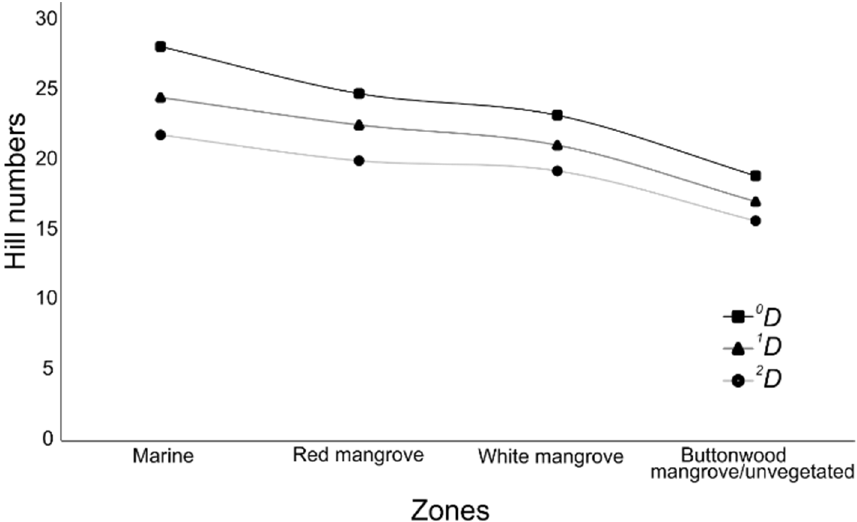
Figure 5. Average value of the three Hill numbers used in the different zones. For beta diversity, the nestedness component (species richness differences) did not show significant differences between zones (t β sne < 1.6, p > 0.2), while the spatial turnover (species replacement) was different, due to the higher values in the ocean (t β stu > 28.94, p < 0.01) compared to the rest of the zones that did not show significant differences among them at the pairwise analyses (t < 0.98, p > 0.32).